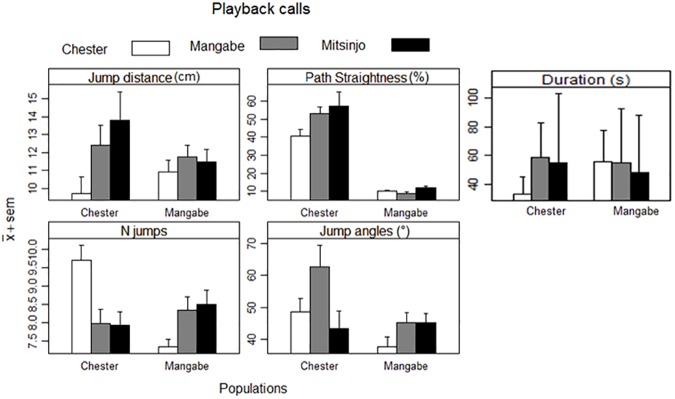
Summary of phonotactic movement results (mean +Standard Error of the Mean) of golden mantilla frogs towards playback calls.